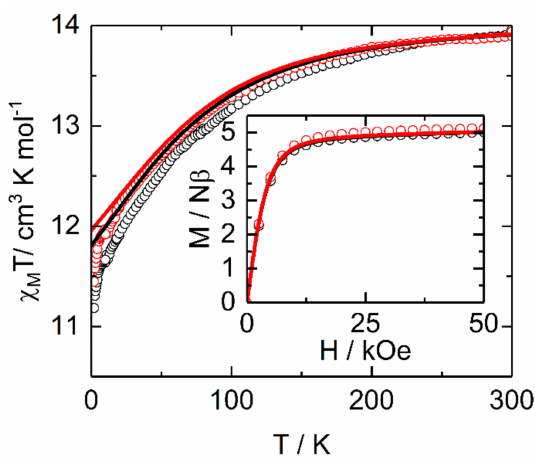
Figure 4. Temperature dependence of χ M T for 1 (black open circles) and 2 (red open circles). In the inset, the field variations of the magnetization at 2 K for 1 (black open circles) and 2 (red open circles). Full black and red lines correspond to the best computed curves.